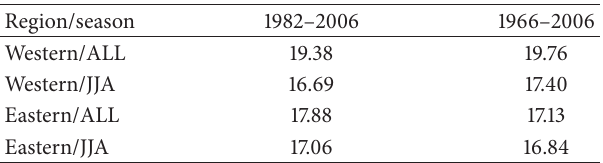
Table 2: THR in mm/6 h for 1982–2006 and 1966–2006 for both regions and ALL and JJA data.